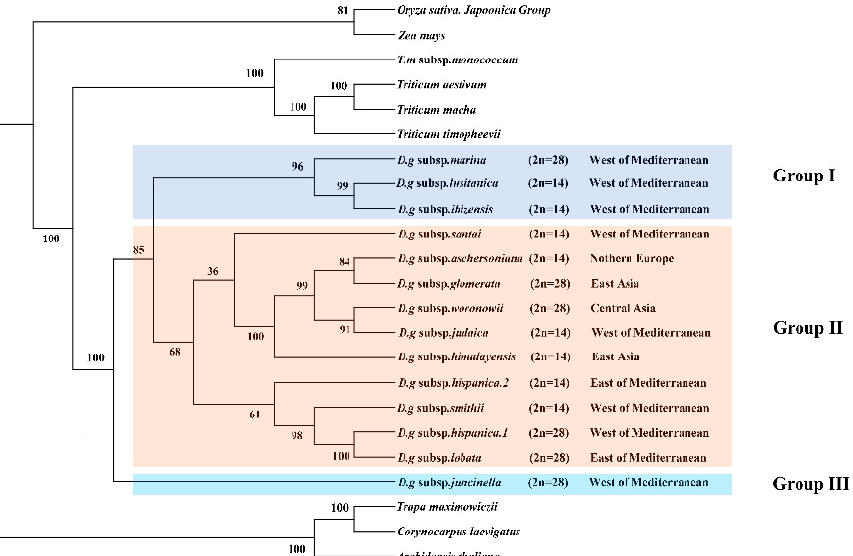
Figure 6. Phylogeny of Dactylis species inferred from complete chloroplast genome dataset. Phyloge- netic tree constructed from D. glomerata subspecies and nine crop complete cp genome sequences using maximum likelihood (ML) method. Bootstrap values are marked above the branches. Arabidop- sis, Corynocarpus and Trapa are used as the outgroups.